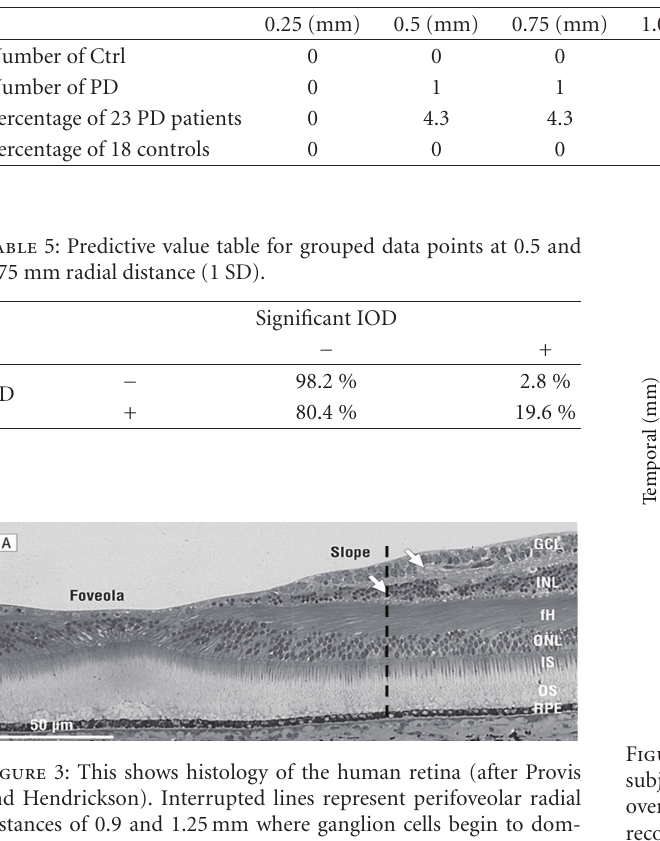
Table 4: Individual subjects outside their group’s retinal thickness mean IOD at 2 control SD at each radial distance (mm).